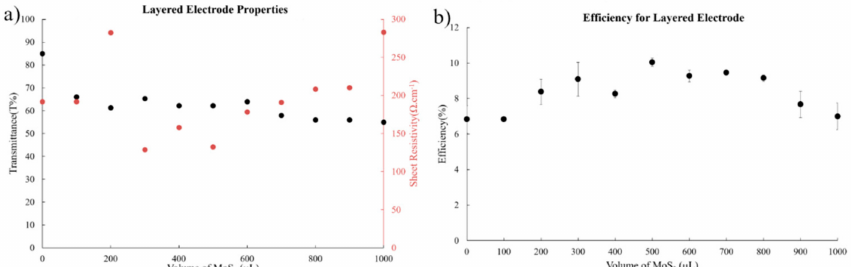
Figure 5. ( a ) Electrode properties for films made with a layer of MoS 2 covered by a film of SWCNTs; ( b ) E ffi ciencies of solar cells with films made with a layer of MoS 2 covered by a film of